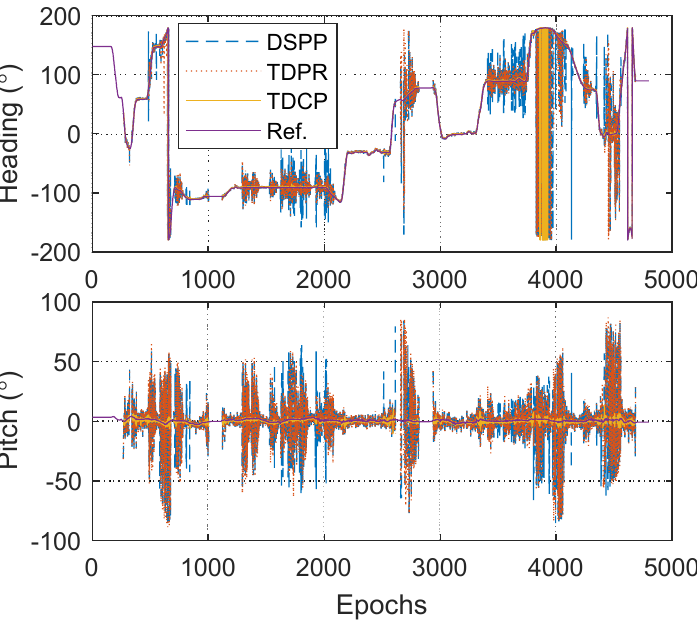
Figure 13. Comparison of the estimated vehicular heading (top) and pitch (bottom) angles using three different algorithms with the reference (Ref.): the direct position difference of the single-point positioning solutions (DSPP), time-differenced pseudorange (TDPR), and time-differenced carrier phase (TDCP).